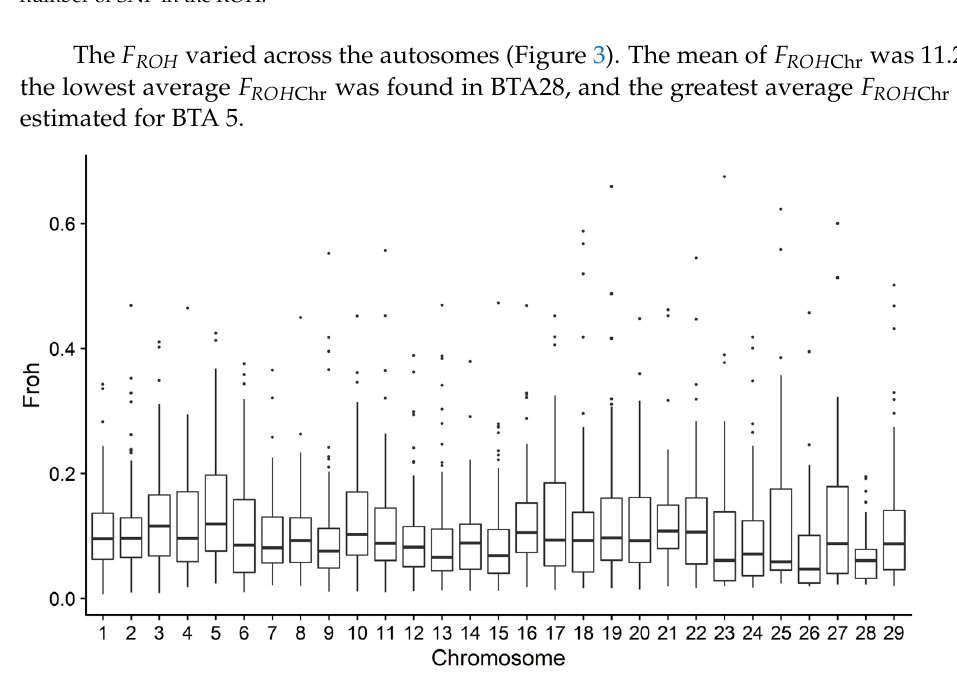
Figure 3. Runs of homozygosity (ROH) based inbreeding in each considered autosome in Tropical Milking Criollo cattle.